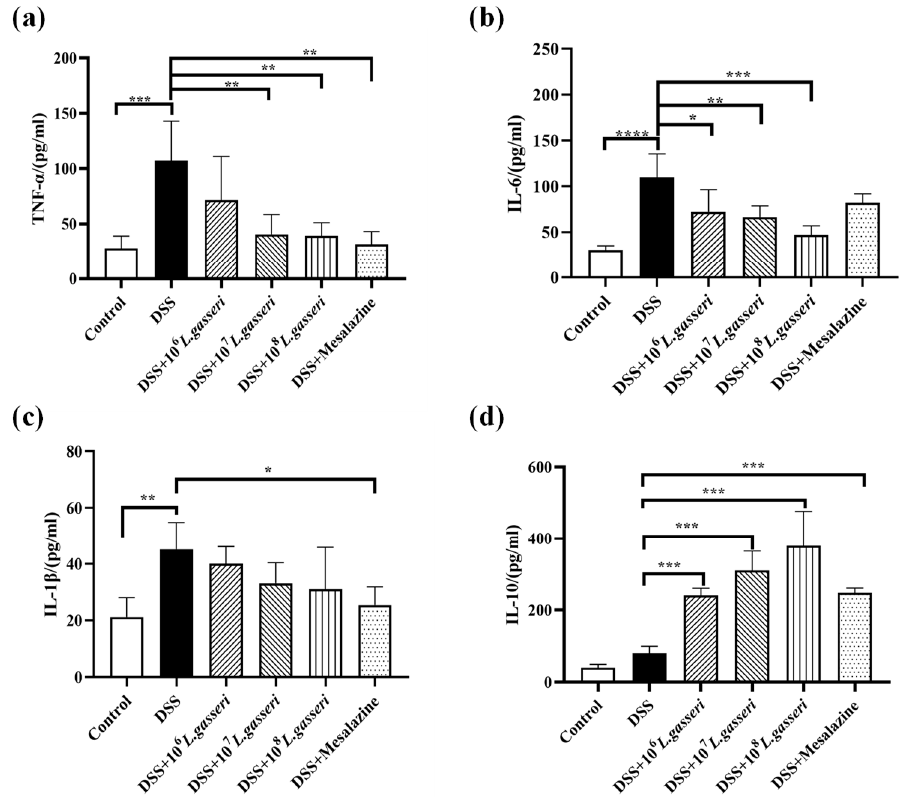
Figure 5. Changes of immune cytokines expression in colitis mice. ( a ) Levels of TNF- α , ( b ) levels of IL-6, ( c ) levels of IL-1 β , and ( d ) levels of IL-10. * p < 0.05, ** p < 0.01, *** p < 0.001, **** p < 0.0001 represent significant difference between groups.